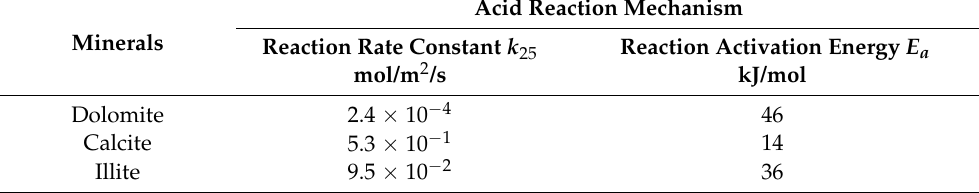
Table 7. Kinetic parameters of the acid reaction mechanism for the main mineral components of the